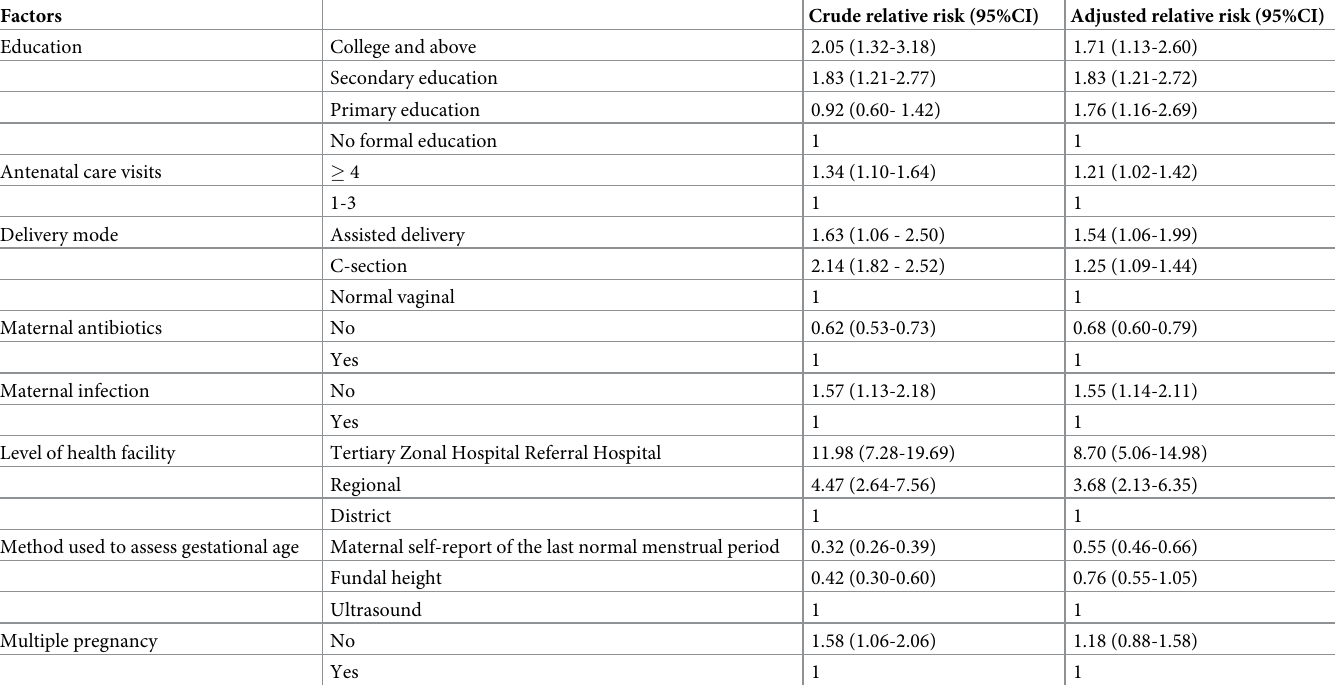
Table 4. Univariate and multivariate analysis of the factors associated with administration of